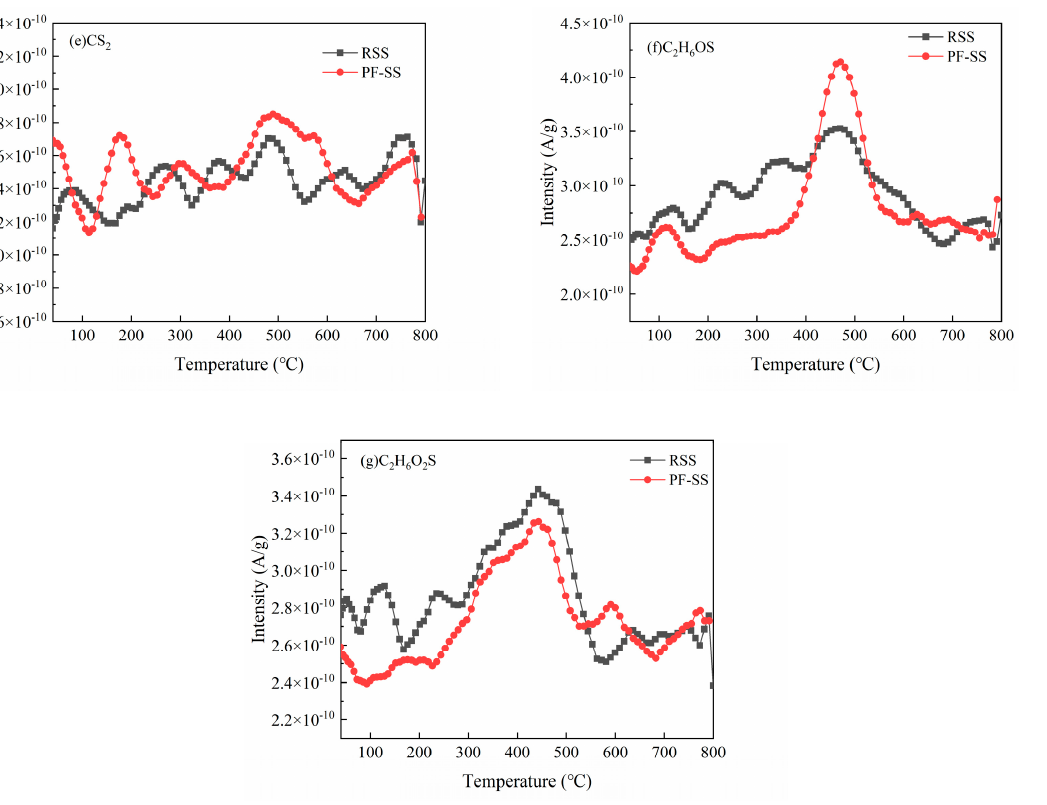
Figure 4. Main S-containing pollutant gas products released during the pyrolysis of different sludge samples. ( a ) H 2 S ( b ) CH 3 SH ( c ) COS ( d ) SO 2 ( e ) CS 2 ( f ) C 2 H 6 OS ( g ) C 2 H 6 O 2 S. Table 4. Peak integrated areas of products of gases containing S pollutants.